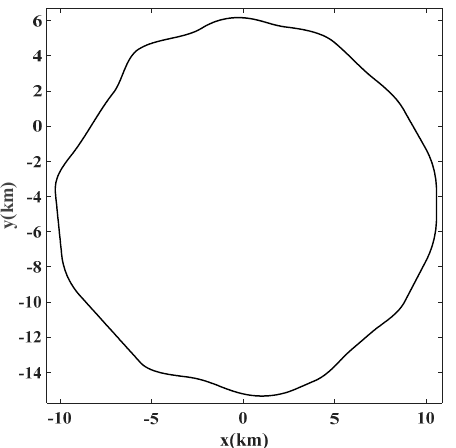
Figure 5. Test track for driving tests.